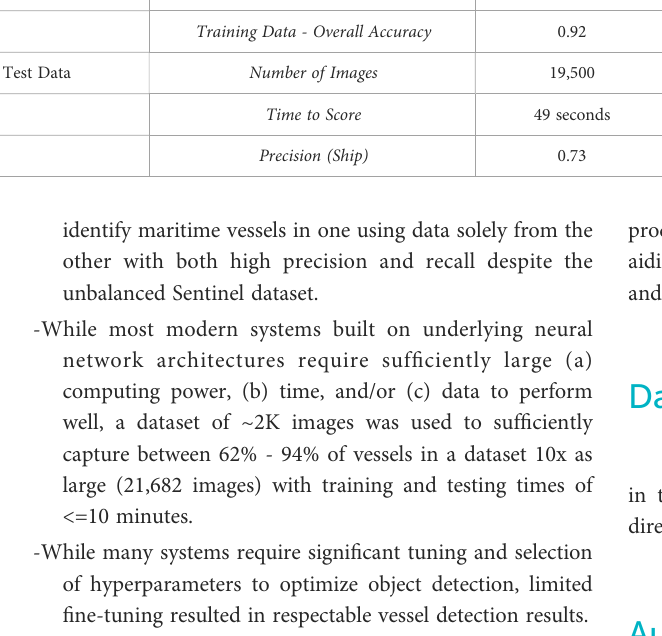
-Introduction of ship classi fi cation algorithms for speci fi c